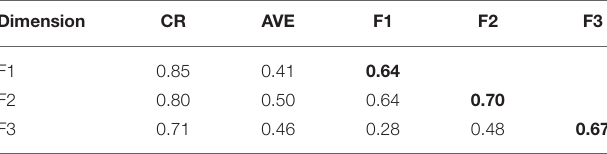
TABLE 8 | CR, AVE, and correlation coefficients between factors in Behavior Tendency subscale.